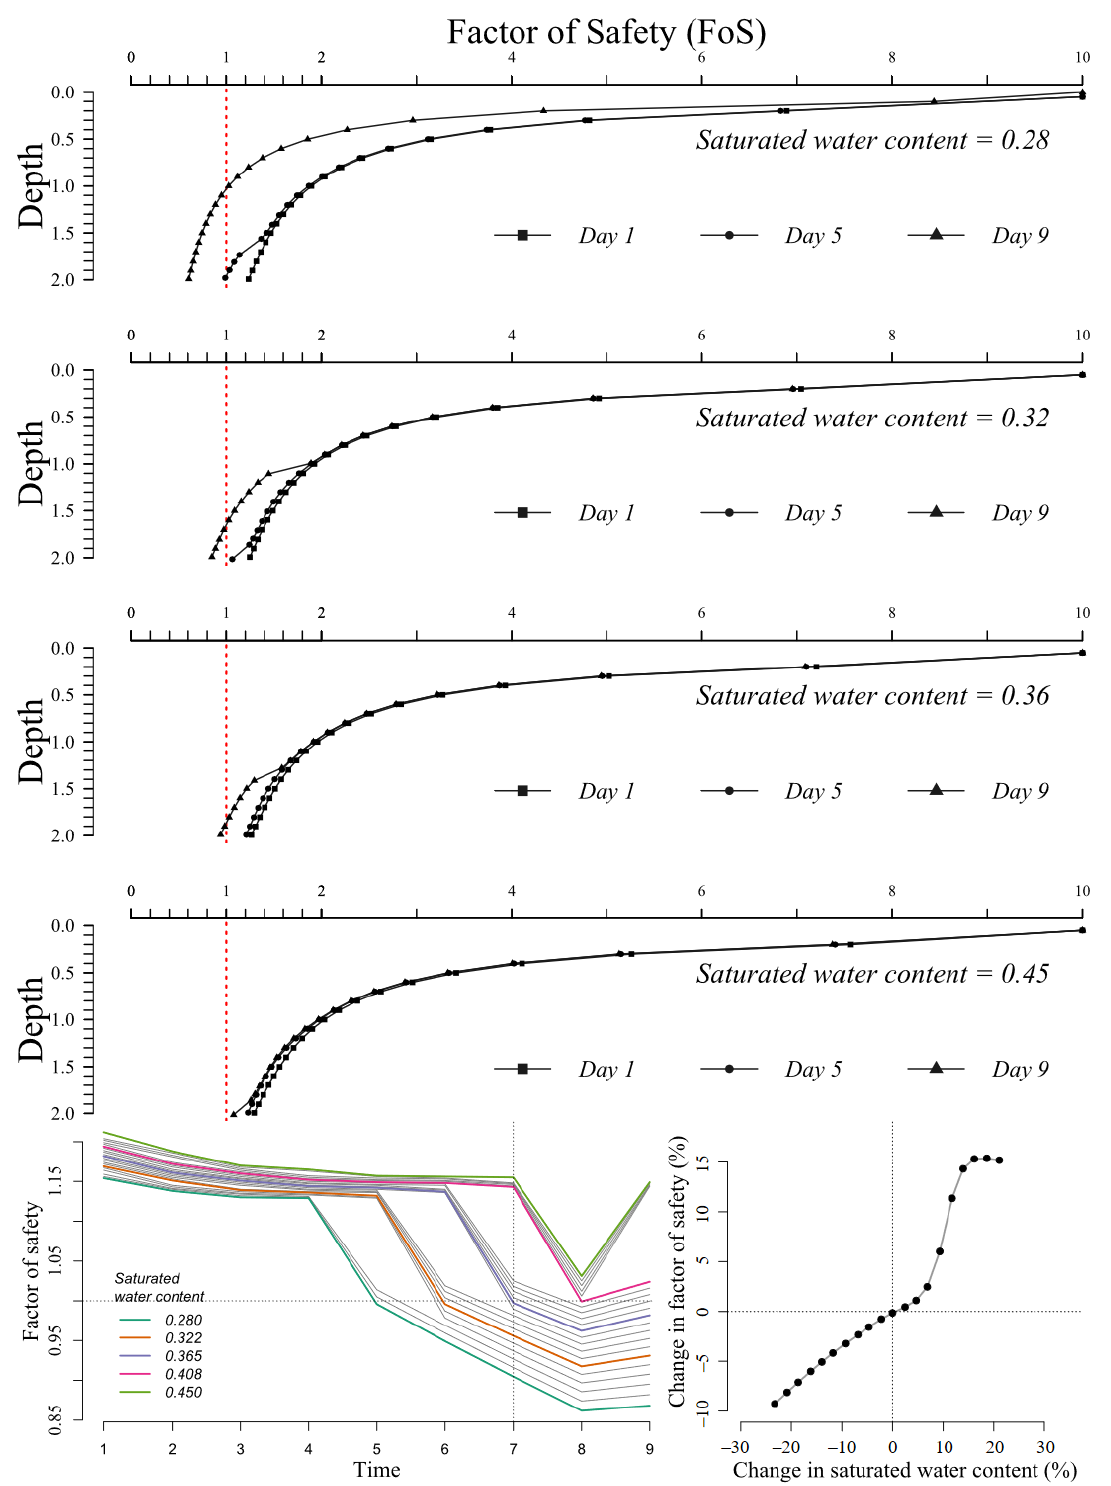
Figure 15. Sensitivity analysis of saturated water content ( θ s ): ( Top ) changes in FoS with depth for a 9 − day period with respect to the different θ s values; ( Bottom Left ) changes in FoS and landslide initiation time with change in θ s values. ( Bottom right ) Percentage change in FoS in accordance with the percentage change θ s . The vertical dotted line on the bottom left indicates the time at which the median value of the selected parameter crossed the threshold FoS, and the horizontal line indicates the corresponding threshold FoS, which is